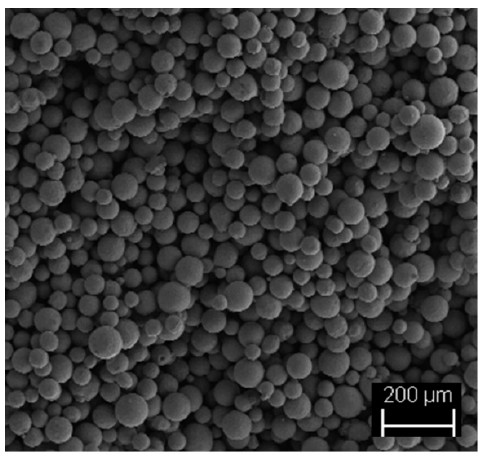
Figure 2. SEM image of the Ti-6Al-4V pre-alloyed powder used in the experiments.